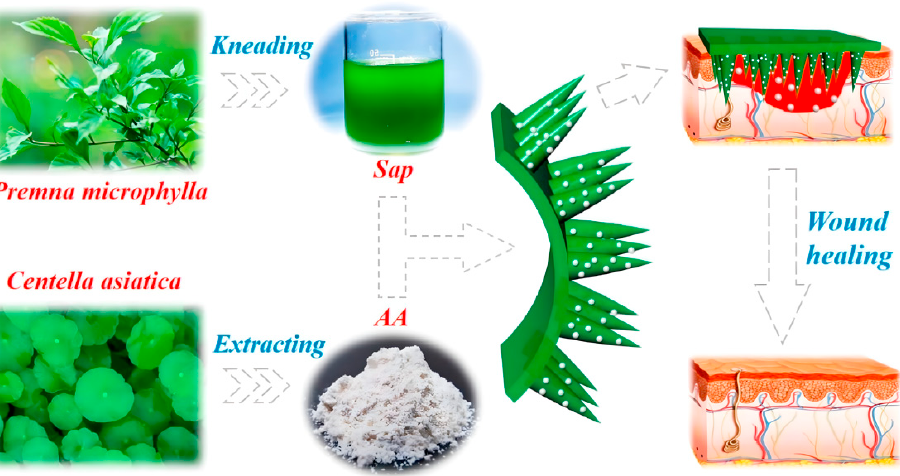
Figure 8. A schematic diagram exhibiting the application of Chinese herb MN (CHMN) patch made from Premna microphylla and Centella Asiatica extractions for wound healing [21]. Reproduced with permission from Junjie Chi, Bioactive Materials; published by KEAI, 2021.